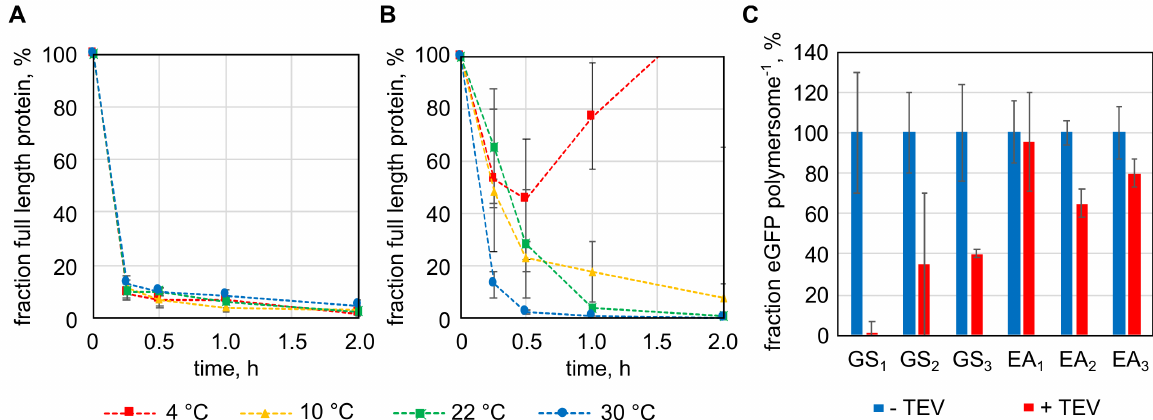
Figure 3. Targeted proteolytic release of protein domains from the surface of polymersomes by tobacco etch virus (TEV) protease. ( A ) and ( B ): proteolysis of enhanced green fluorescent protein (eGFP) with TEV protease recognition sequences and the Cytb5 (cid:48) membrane anchoring peptide (A: eGFP-GS 2 /TEV-Cytb5 (cid:48) , B: eGFP-EA 2 /TEV-Cytb5 (cid:48) ) in solution. ( C ): TEV protease proteolysis of immobilized fusion proteins of eGFP, the TEV recognition sequence flanked by different linkers (EA: EAAAK-linker, GS: GSSSS-linker, numbers indicate repeats of the EA or GS peptide) and the Cytb5 (cid:48) membrane anchor. Error bars represent the standard deviation in technical